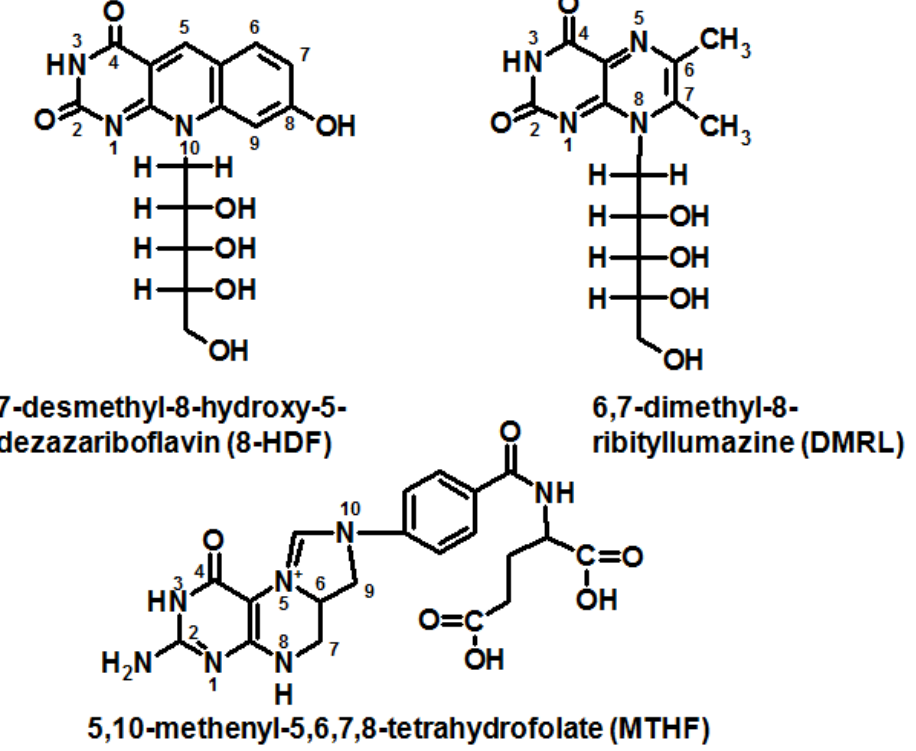
Figure 23. Antenna molecules of CPF proteins.